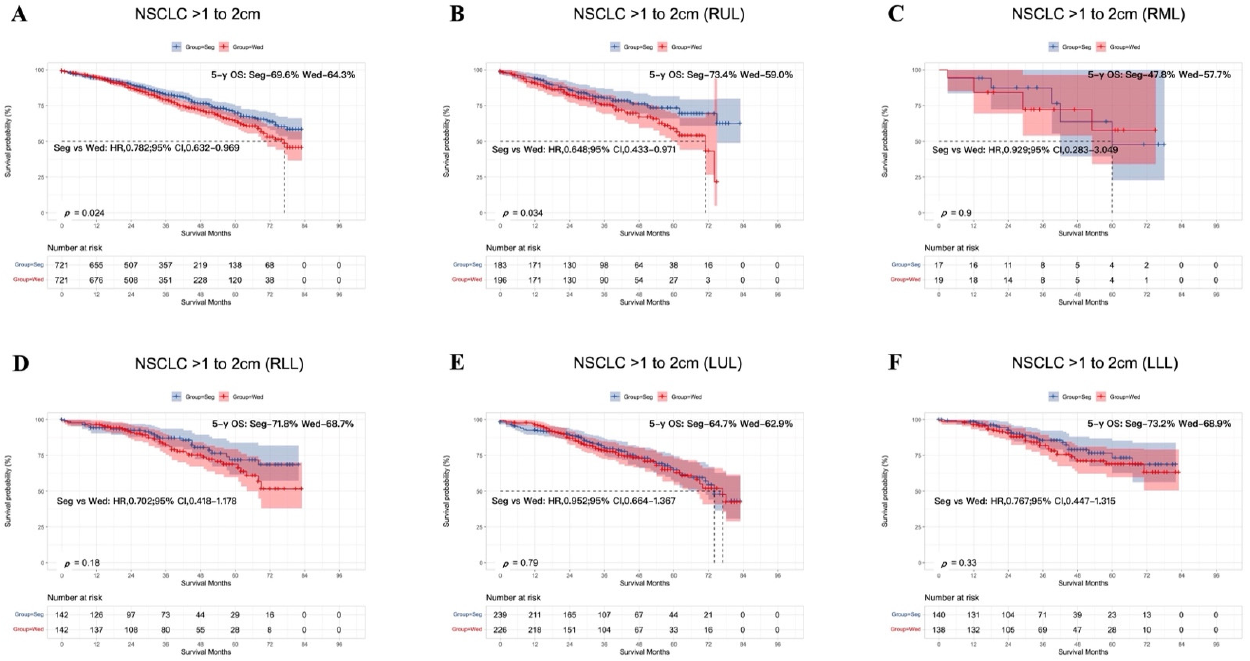
Figure 4. Kaplan–Meier survival curves after segmentectomy or wedge resection in NSCLC patients with tumors of 1–2 cm after PSM ( A ). Survival curves for the RUL ( B ), RML ( C ), RLL ( D ), LUL ( E ), and LLL ( F ) after PSM.